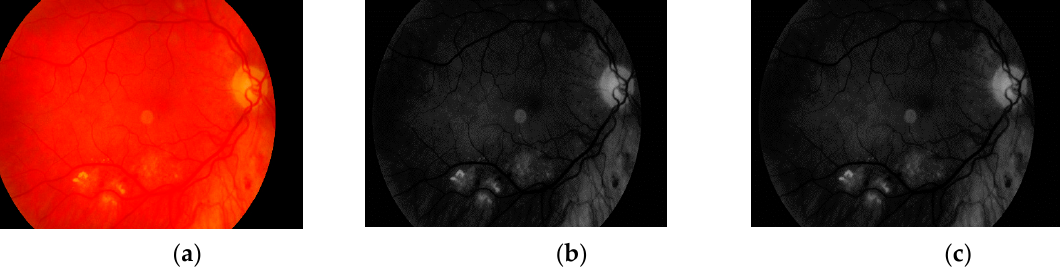
Figure 10. ( a ) Original image, ( b ) image after conversion to grayscale with green channel and ( c ) image after noise removal.